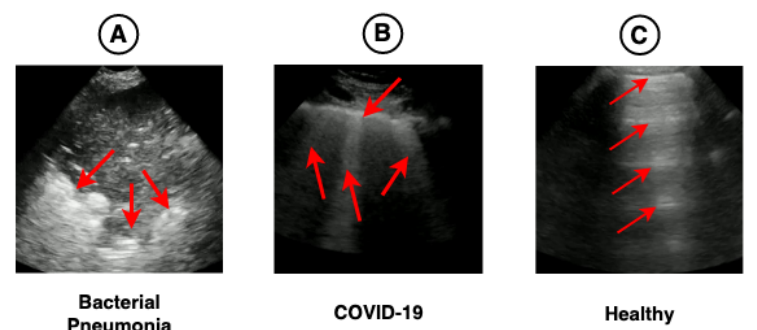
Figure 1. Image ( A ) shows a large consolidation area related to the diagnoses of bacterial pneumonia. Image ( B ) shows B-lines (vertical lines) and an irregular pleura line, both related to lung ultrasound (LUS) diagnosis of COVID-19. Image ( C ) is a lung with a healthy diagnosis, where there are A-lines (horizontal lines) and a regular pleural line. Red arrows were manually added to show the location of pathologies in the